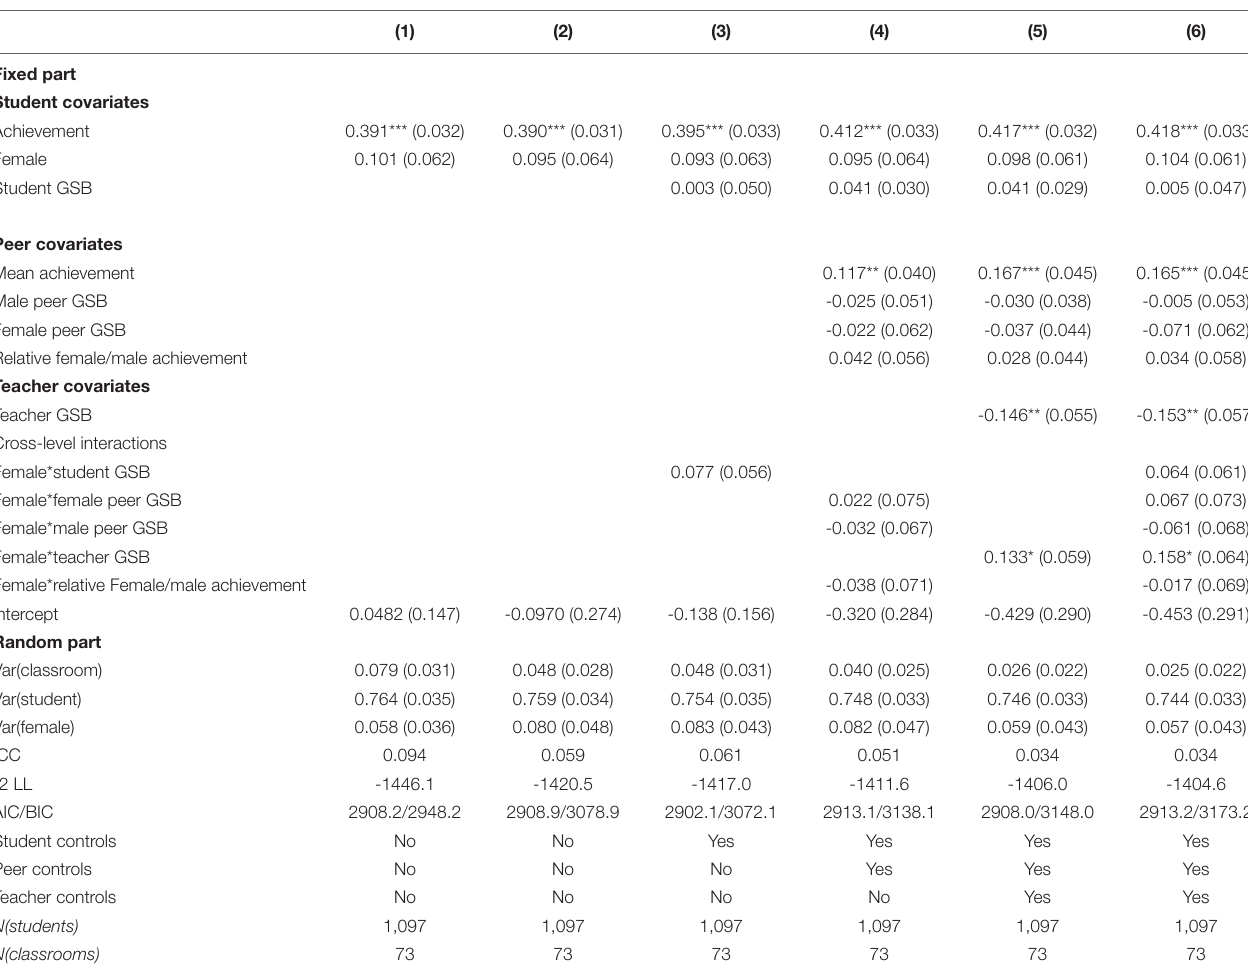
TABLE 2 | Results from a multilevel model of self-concept in